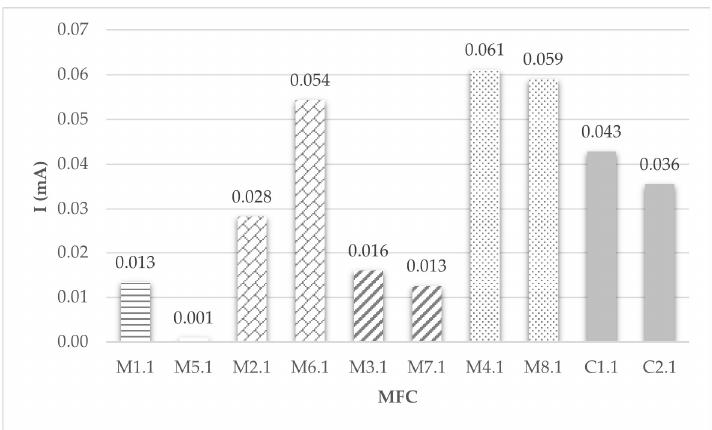
Figure 5. Maximum current recorded in each MFC during closed-circuit operation; each bar corre- sponds to an experiment using the experimental design.